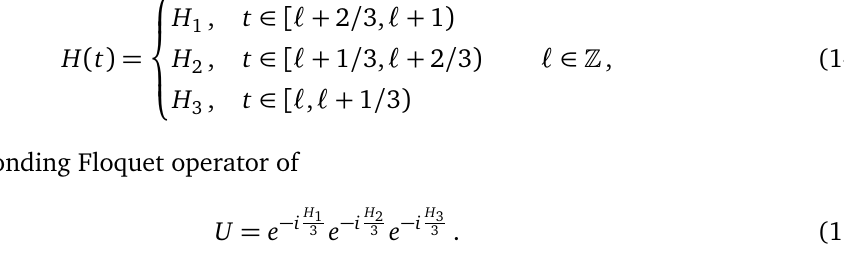
Figure 1: Schematic of a cubic-root system obtained from the procedure of Eq. (12). In the parent system, a particle (marked by black star) evolves under H H over the course of a period. In the corresponding cubic-root system, a particle 1 living in a given subsystem effectively evolves under the same three Hamiltonians only when viewed over the course of three